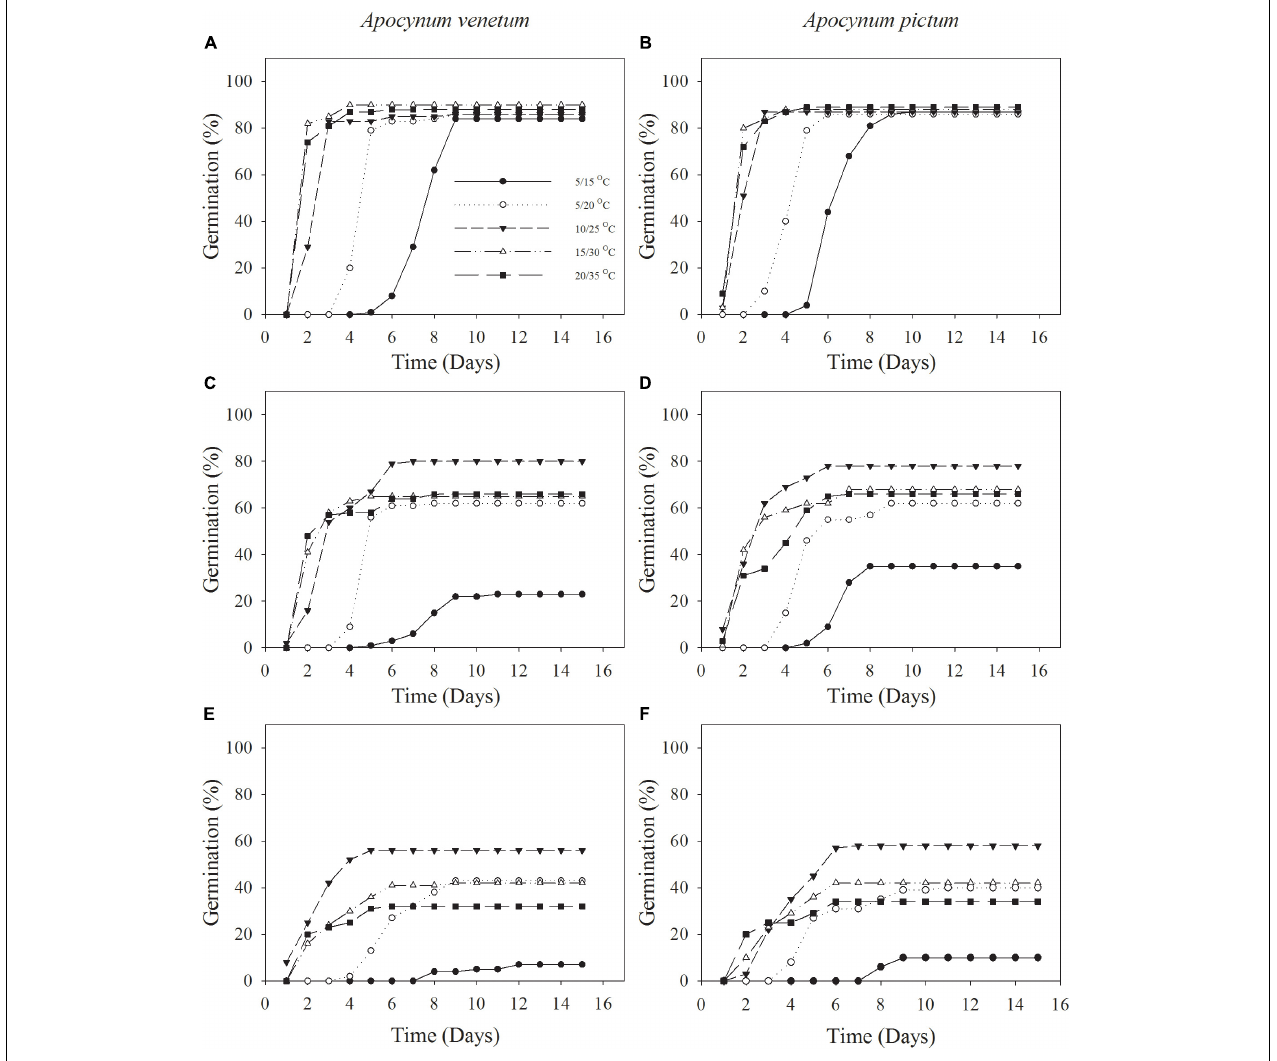
FIGURE 2 | Cumulative germination percentages of Apocynum venetum and Apocynum pictum seeds stored for 0 year (A,B) , 1 year (C,D) , and 2 years (E,F) under different temperatures. TABLE 1 | Effect of temperature on germination index of Apocynum venetum and Apocynum pictum seeds stored for 0, 1, or 2 years. Temperature ( ◦ C) Apocynum venetum Apocynum